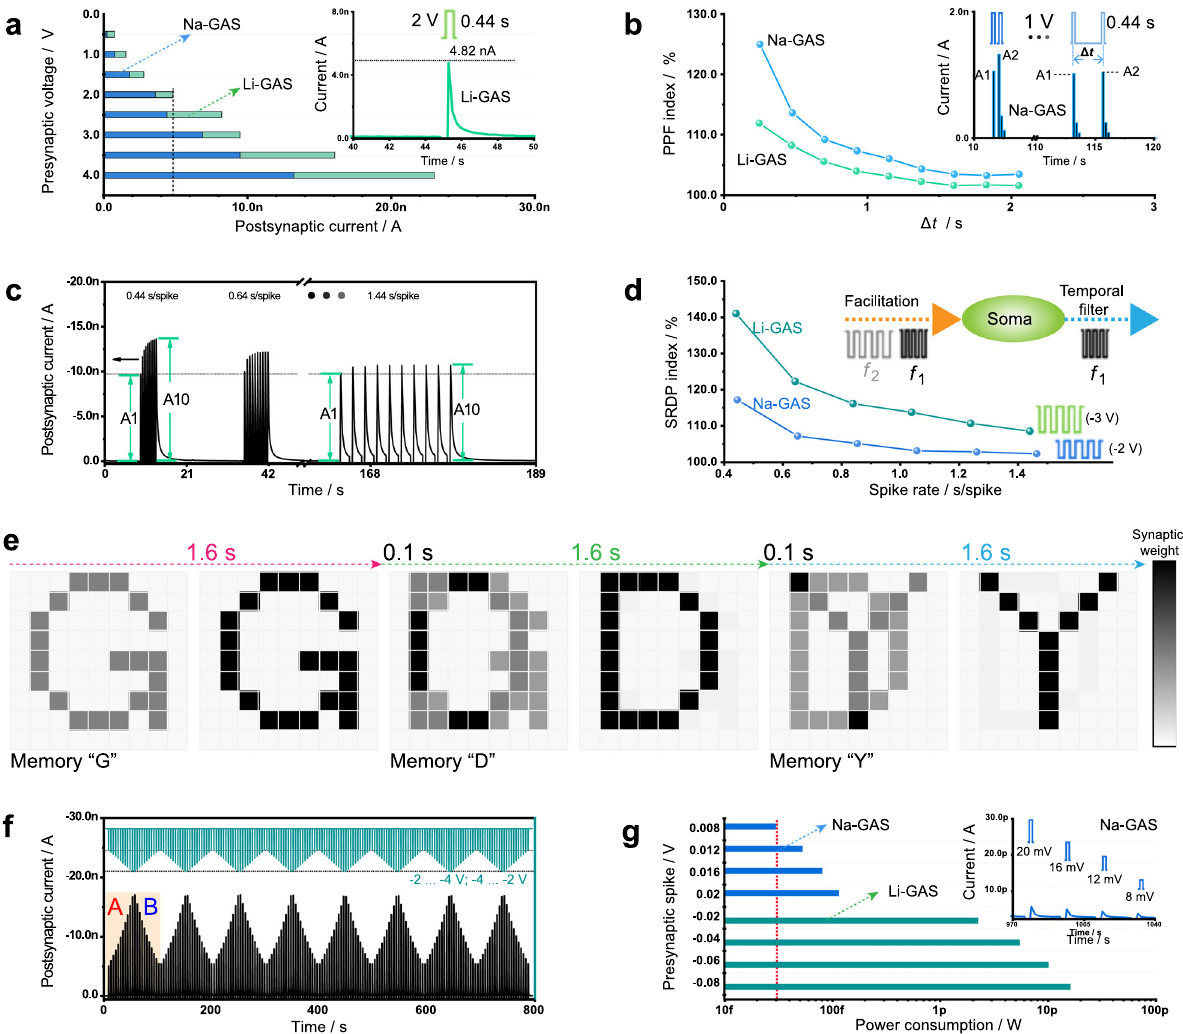
Fig. 3 Short-term plasticity in Li- and Na-GASs. a Peak value of the postsynaptic current with different positive pulse amplitudes in Li-GAS and Na-GAS, respectively. Inset: Postsynaptic current triggered by a single spike in Li-GAS. b PPF behavior emulated by two consecutive positive pulses ( + 1 V) in Li-GAS and Na-GAS. Inset: Postsynaptic currents triggered by two spikes in Na-GAS. c Postsynaptic current at different frequencies in Li-GAS. d Gain of postsynaptic currents (SRDP index; A10/A1×100%) plotted as a function of presynaptic spike rate in Li-GAS (-3 V) and Na-GAS (-2 V). e Real-time storage and transformation of letters G, D, and Y. f Postsynaptic current triggered by a nonidentical negative pulse sequence in Li-GAS. g Impulse responsivity at the millivolt level and corresponding power consumption in Li-GAS and Na-GAS. Inset: Postsynaptic currents triggered by a series of positive presynaptic spikes with voltage amplitudes from 8 to 20 mV in